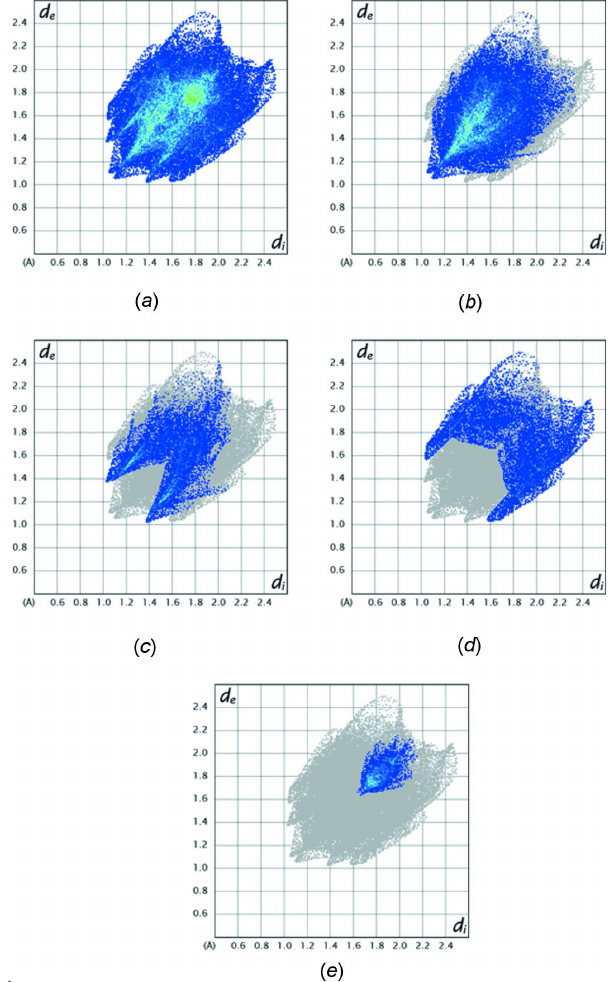
Figure 4 Two dimensional fingerprint plots showing ( a ) all intermolecular inter- actions and those delineated into ( b ) H (cid:2)(cid:2)(cid:2) H, ( c ) H (cid:2)(cid:2)(cid:2) O/O (cid:2)(cid:2)(cid:2) H, ( d ) H (cid:2)(cid:2)(cid:2) C/C (cid:2)(cid:2)(cid:2) H and ( e ) C (cid:2)(cid:2)(cid:2) C